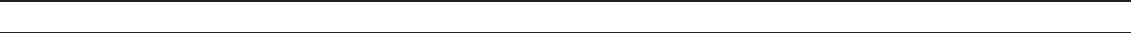
Table 1. Genetic Algorithm.